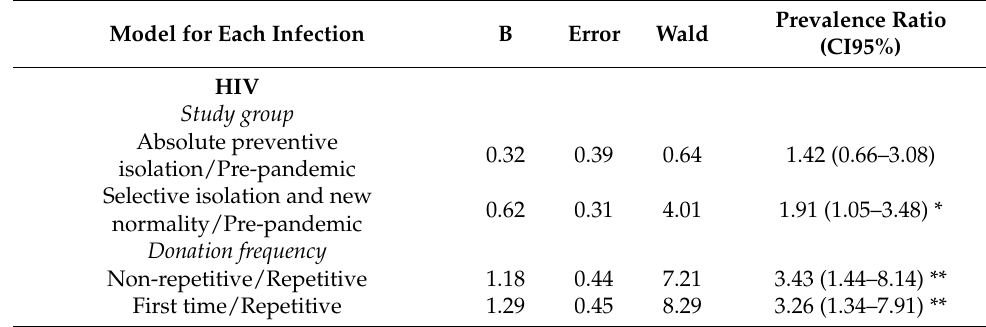
Table 4. Multivariate regression for factors associated with HIV, HBV (anti-HBc) and HTLV I-II